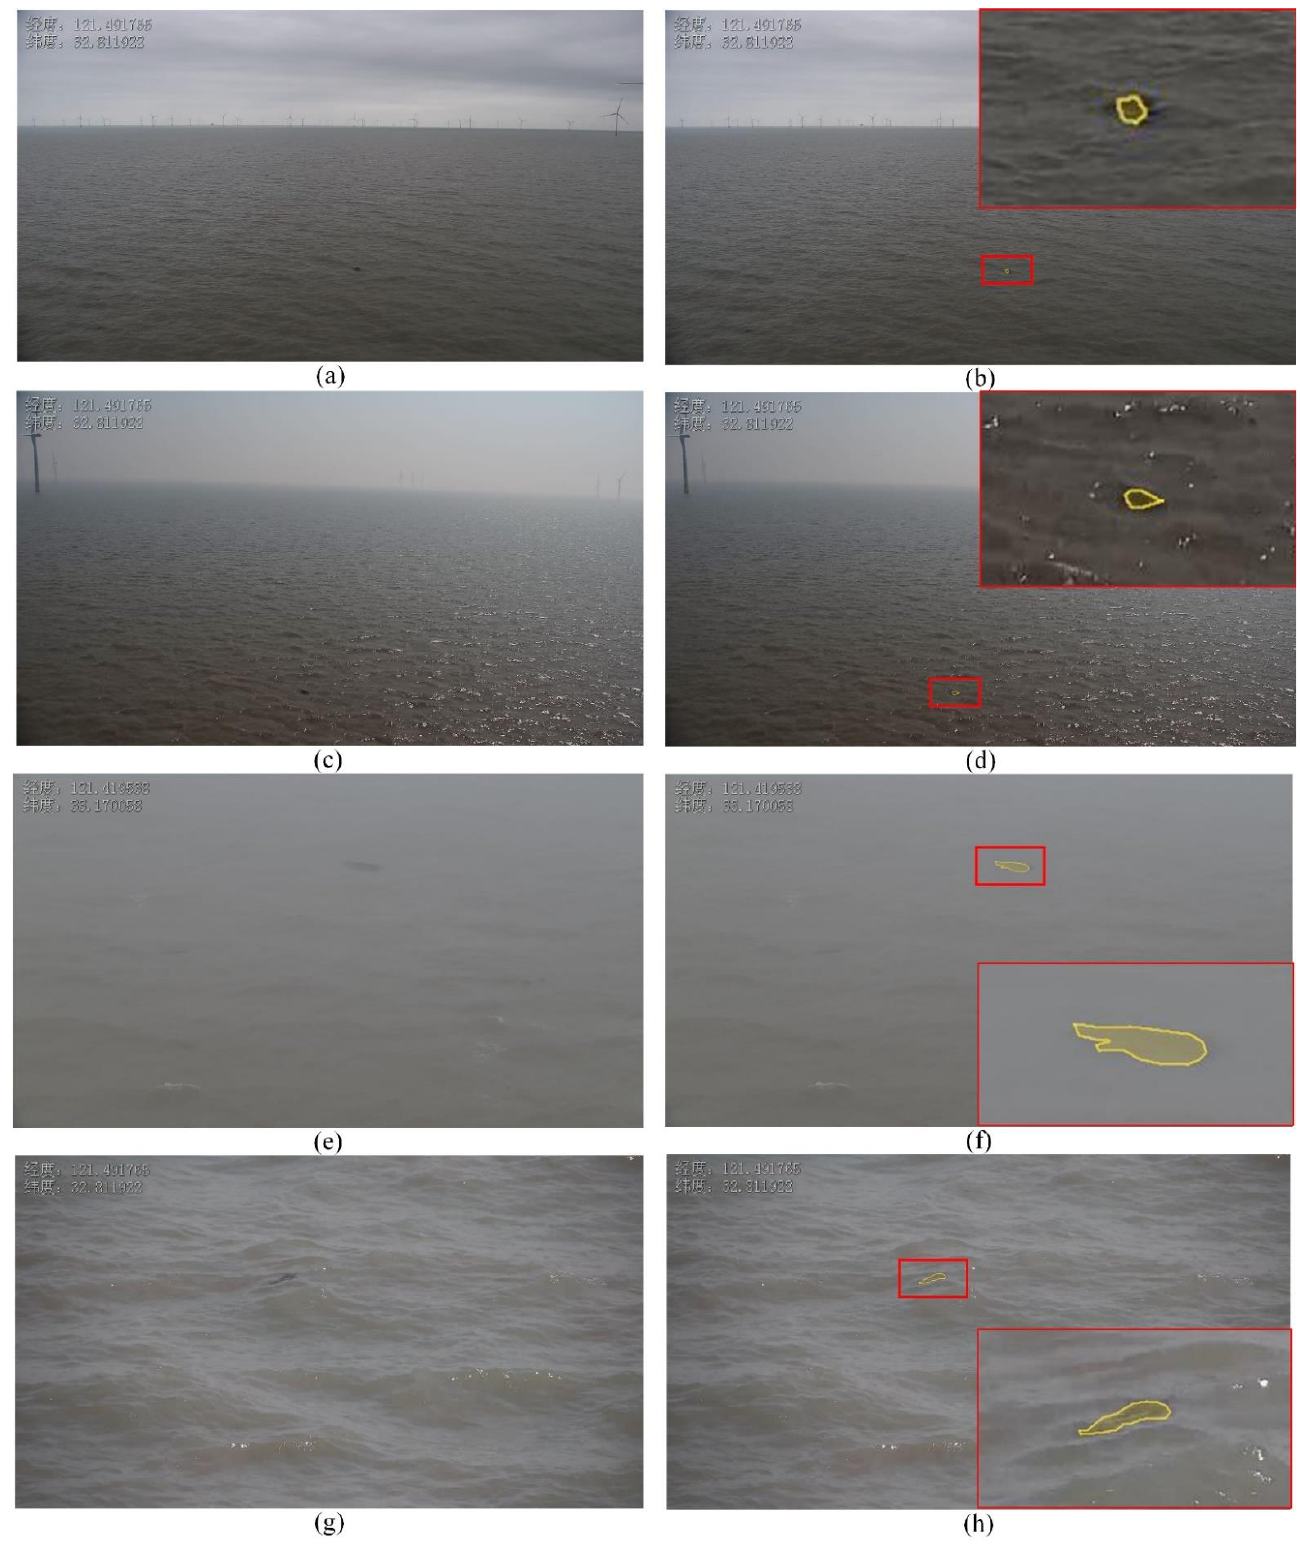
Figure 23. The results of AlgaeFiner in cloudy, foggy and wave scenes: ( a , c ) are the cloudy scene, ( e ) is the foggy scene, ( g ) is the wave scene, and ( b , d , f , h ) are the results of the images ( a , c , e , g ).